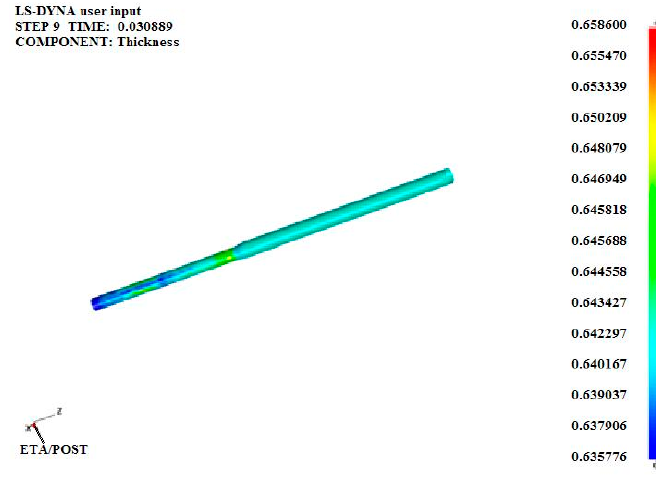
Figure 19. Wall thickness after the eleventh draw s n = 0.0635 mm.